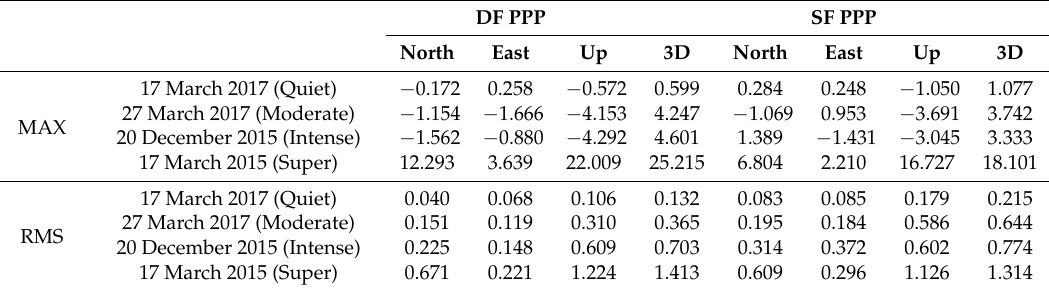
Table 2. The maximum (MAX) values and root mean square (RMS) statistics of GPS DF and SF PPP during the quiet, moderate, intense, and super storms period (Unit: m). DF PPP SF PPP North East Up 3D North